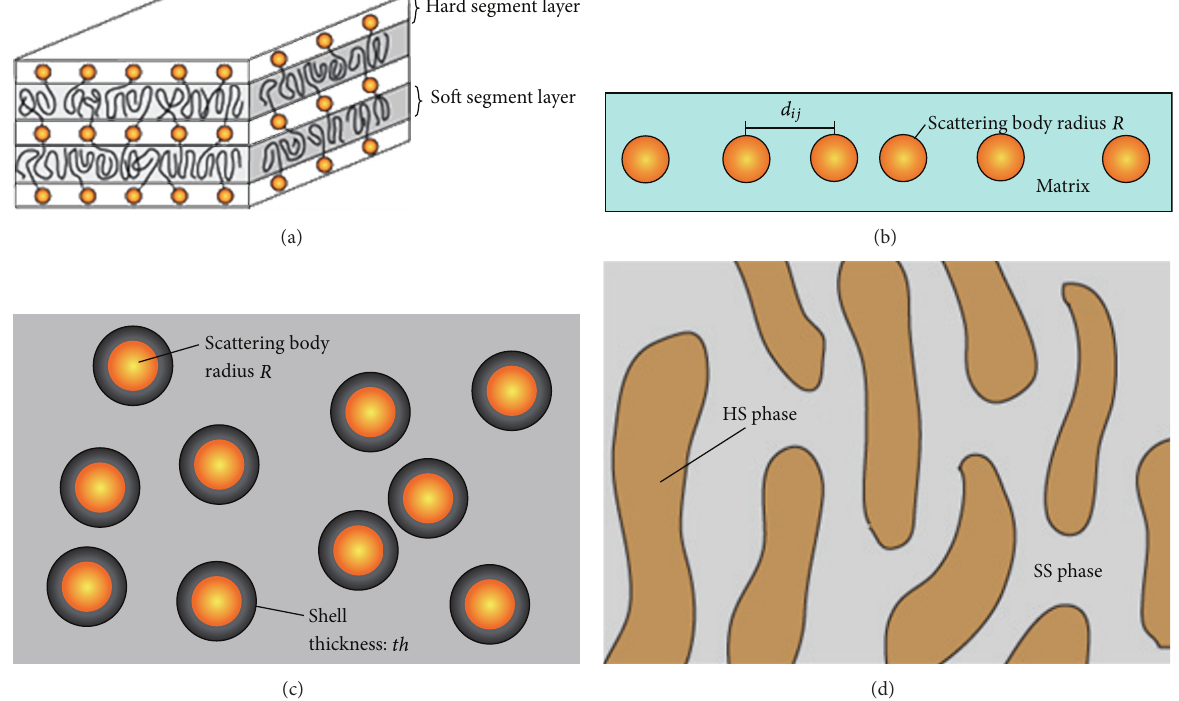
F 1: e schematic diagram of PU segmentations according to (a) lamellar, (b) Zernike-Prins, (c) Percus-Yevick, and (d) Teubner-Strey models. T 1: Parameters obtained from the �tting of SAXS peaks of PU composites with four theoretical models. Co loading (wt.